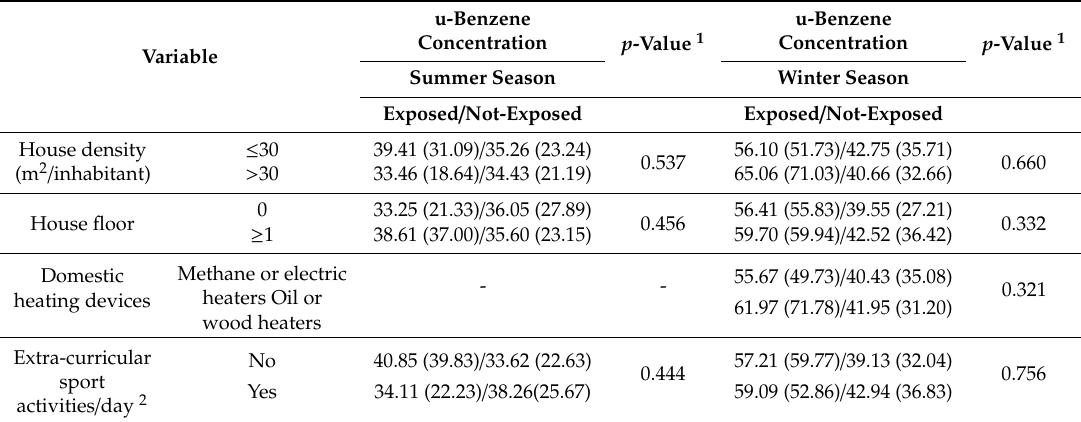
Table 5. u-Benzene concentrations (ng L − 1 ) according to home characteristics and the practice of an extra-curricular sport activity, comparing ETS exposed and not-exposed